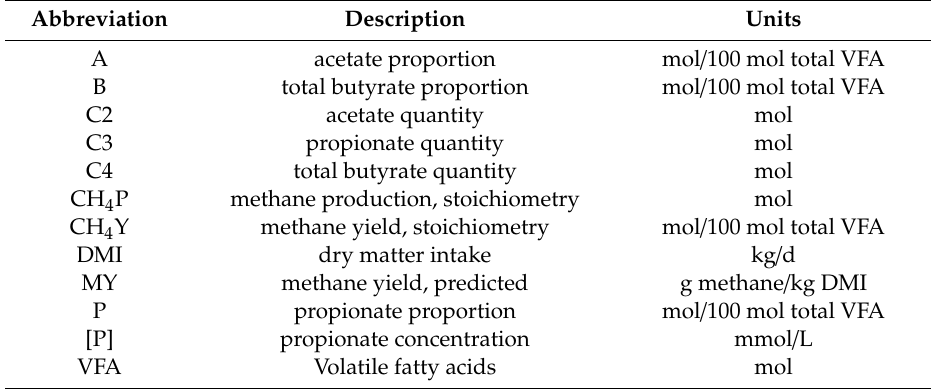
Table 1. Abbreviations, their descriptions and units for variables and parameters used in the